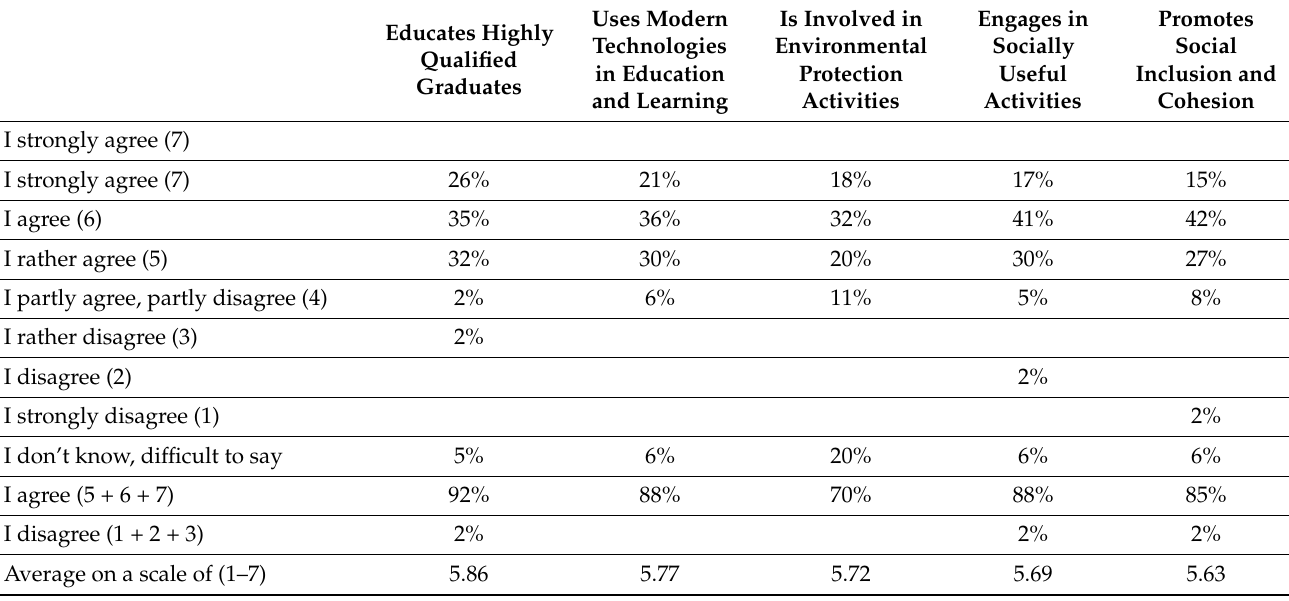
Table 4. Local government representatives’ acceptance of statements about the activities of HEIs (Part 1).